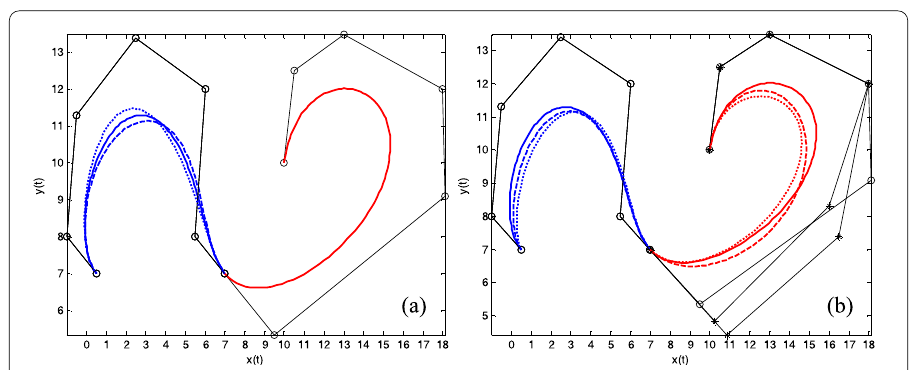
Figure 8 Examples of shape adjustment of G 1 smooth